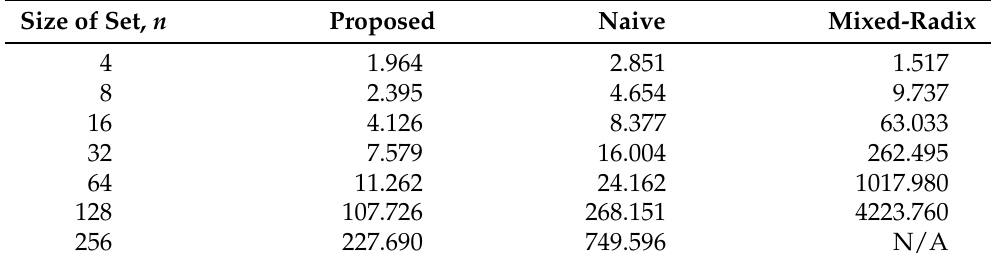
Table 3. Running times (in milliseconds) of the different approaches for calculating the maximum element of an array of RNS numbers on an NVIDIA RTX